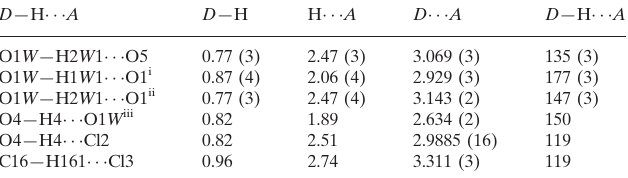
Hydrogen-bond geometry (A˚ , (cid:3) ). D —H (cid:2)(cid:2)(cid:2) A D